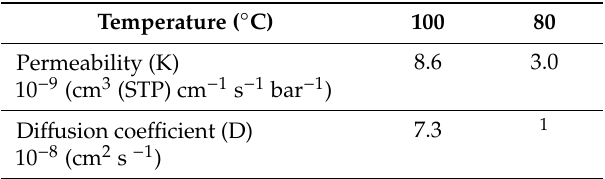
Table 1. Transport coefficients of CO 2 at 150 barg through PPS.